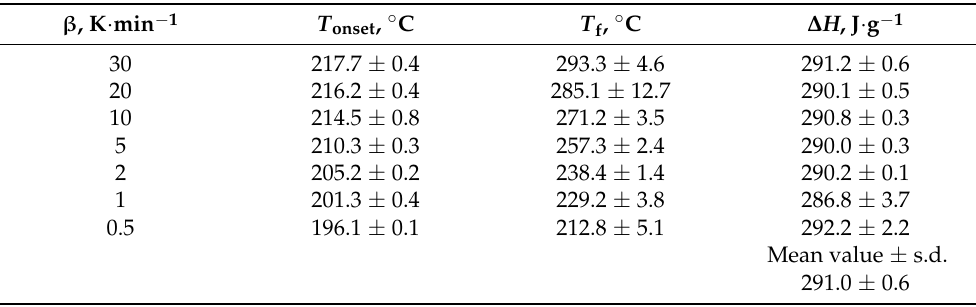
Table 2. T onset , T f , and enthalpy change measured by DSC on a GPZ production batch under nitrogen flow at different heating rates. β , K · min −